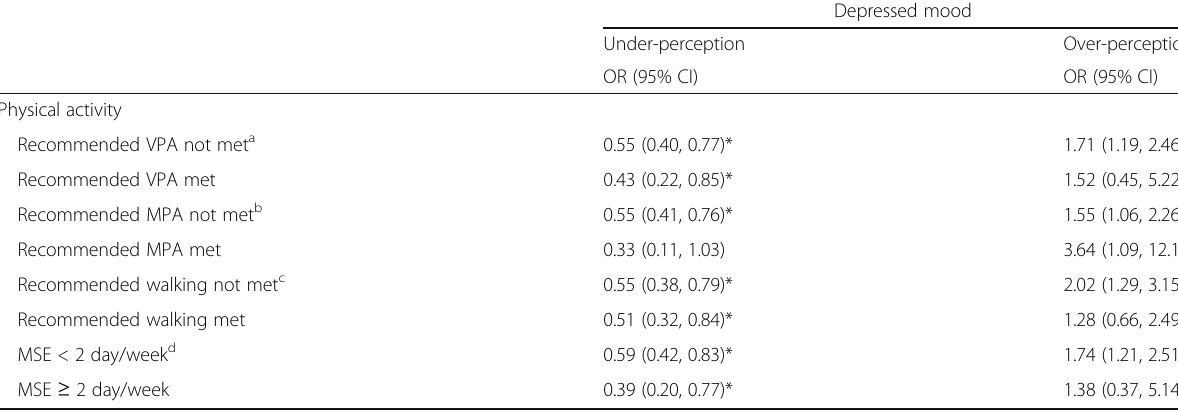
Table 3 Unadjusted associations between body weight misperception (reference group: accurate-perception) and depressed mood by physical activity levels among young South Korean adults aged 20 to 39 years — 2010 – 12 Korea National Health and Nutrition Examination Survey (KNHANES) ( N =